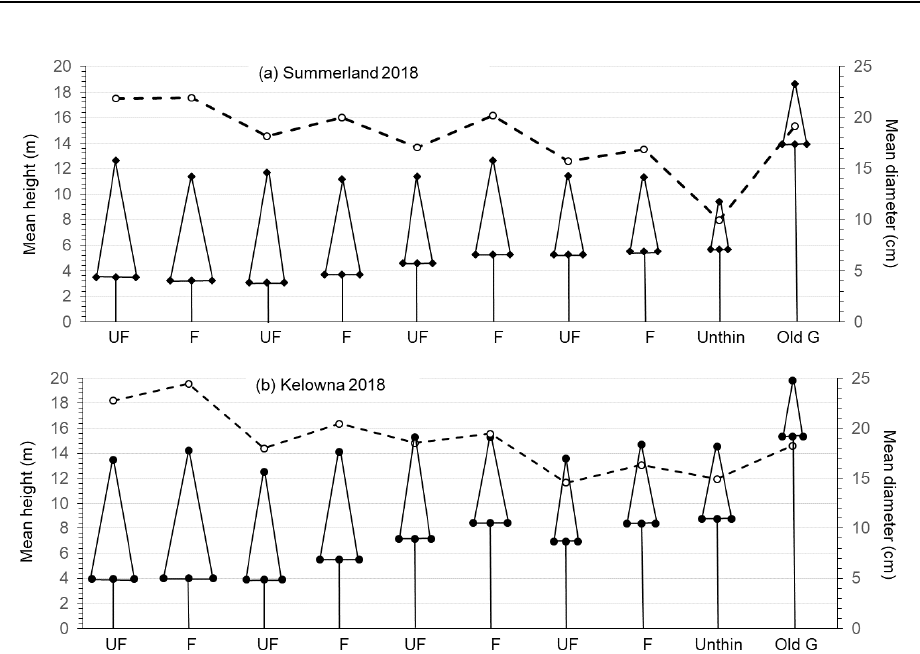
Figure 5. Mean crown architecture of crop trees in the 10 treatment stands at ( a ) Summerland and ( b ) Kelowna 25 years after initiation of treatments. Mean tree height (m) is represented by the top of each tree depiction, and mean tree diameter (cm) is represented by the connected open circle data points. Mean crown width is based on a relative scale among treatment stands. Very low-, low-, medium-, and high-density stands of lodgepole pine with (F) and without (UF) fertilization, and in unthinned (Unthin) and old-growth (Old G) stands.